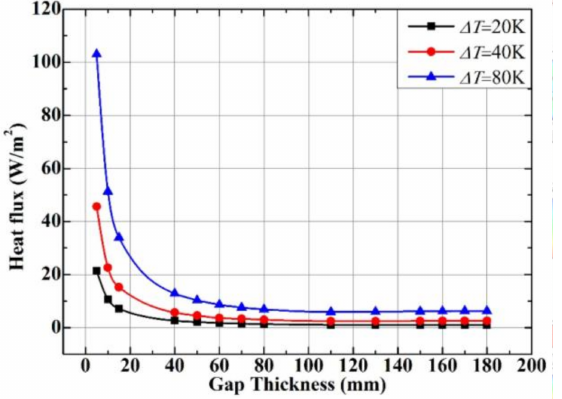
Figure 4. Variation in heat flux with horizontal enclosure gap thickness.